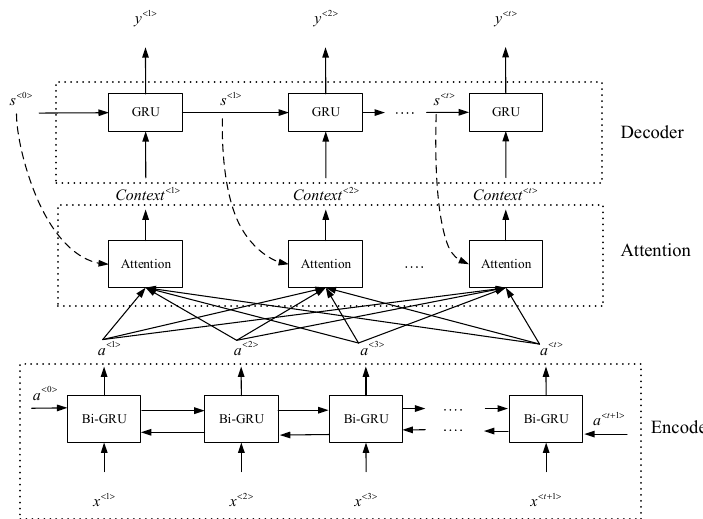
Figure 2. Time Series Model.